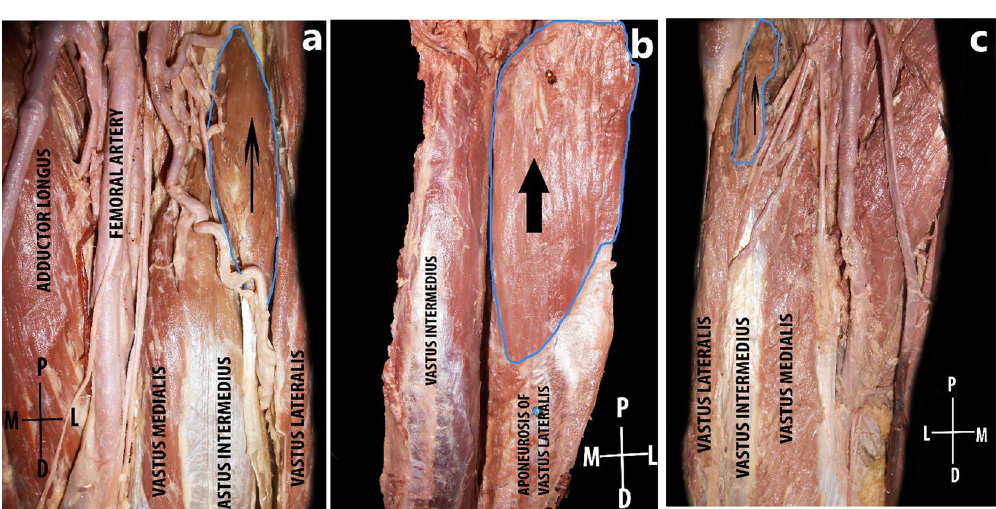
Figure 4. Anterior aspect of the thigh; The rectus femoris muscle has been reflected. The additional muscle head depicted in arrows, presented in different shapes like fusiform ( a ), quadrilateral ( b ), and slender ( c